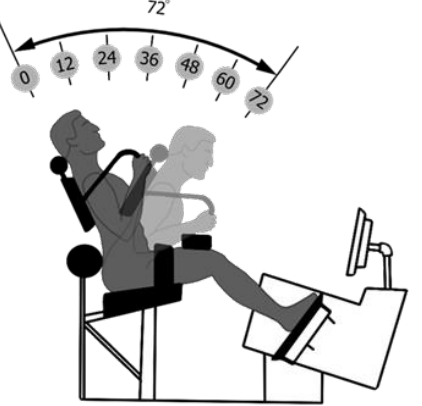
Figure 2. Exercise machine and its restraint system. Training in limited range of motion following a benchmark on the screen.